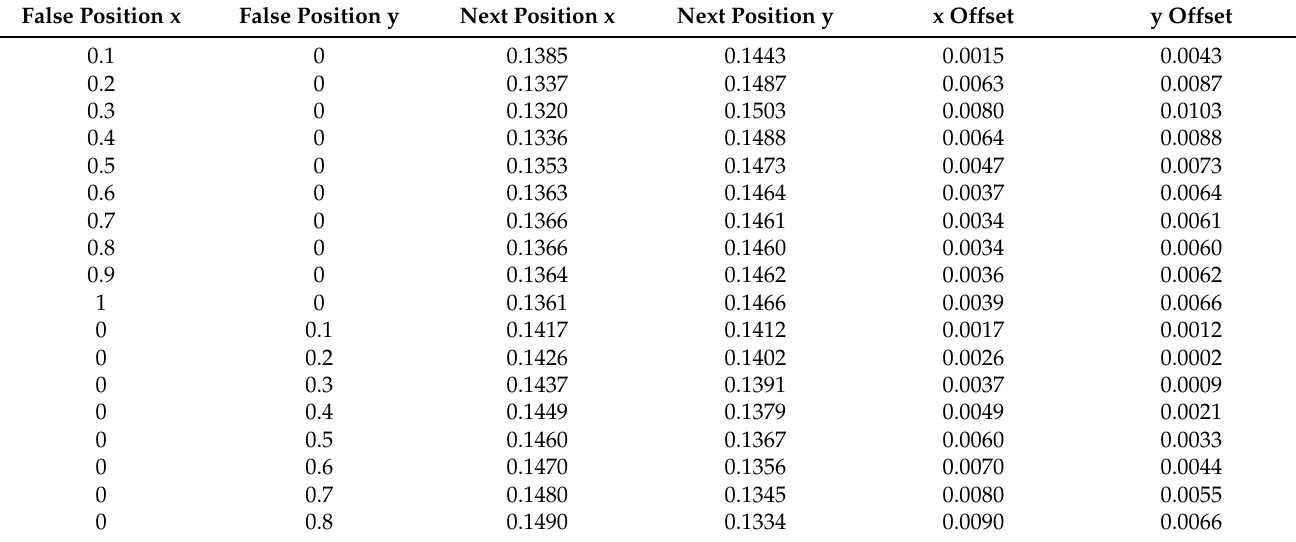
Table 2. Data relationship between false positions and next positions of